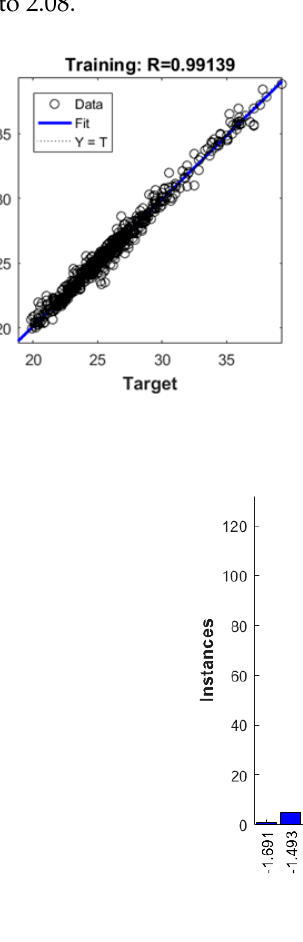
Figure 21. Error histogram. Figure 21. Error